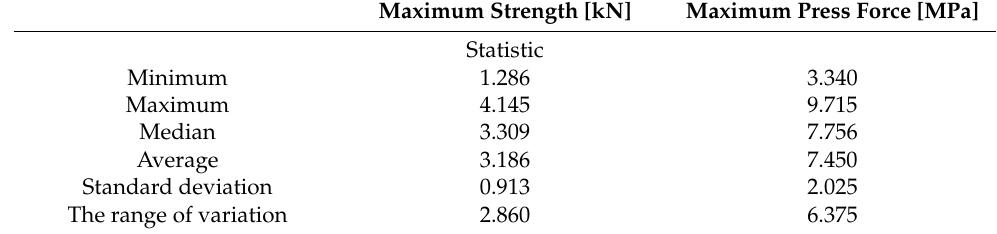
Table 13. Flexural strength tests for basalt dust A for all samples for water − mix ratio = 0.6.